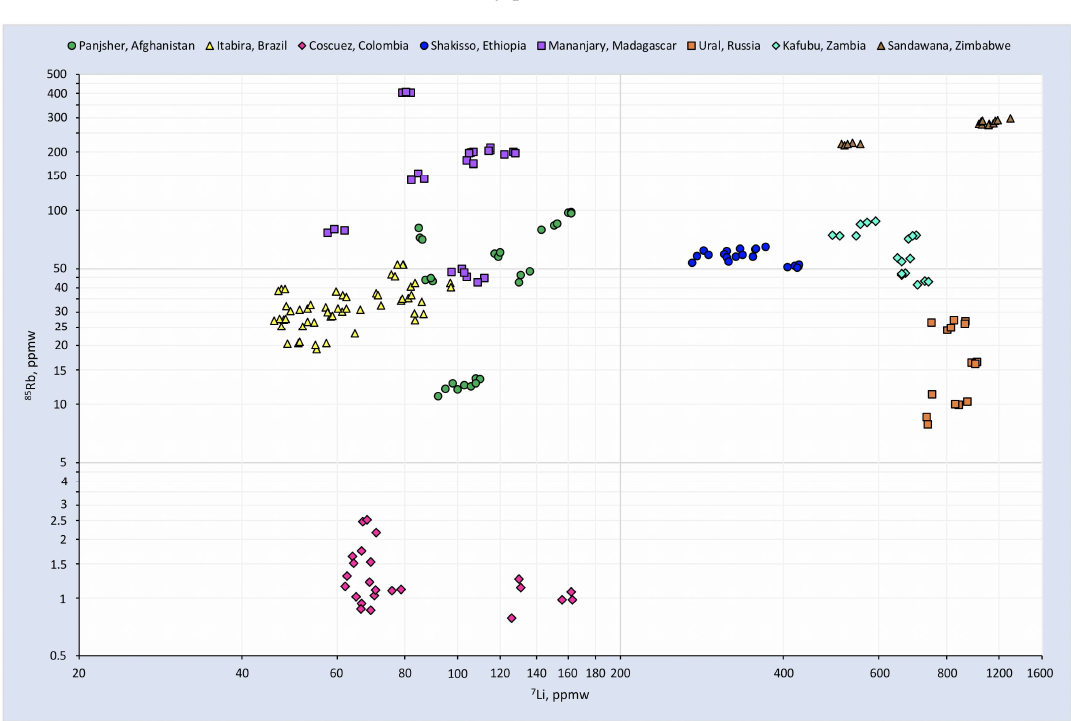
Figure 6. Binary plot of 7 Li vs. 85